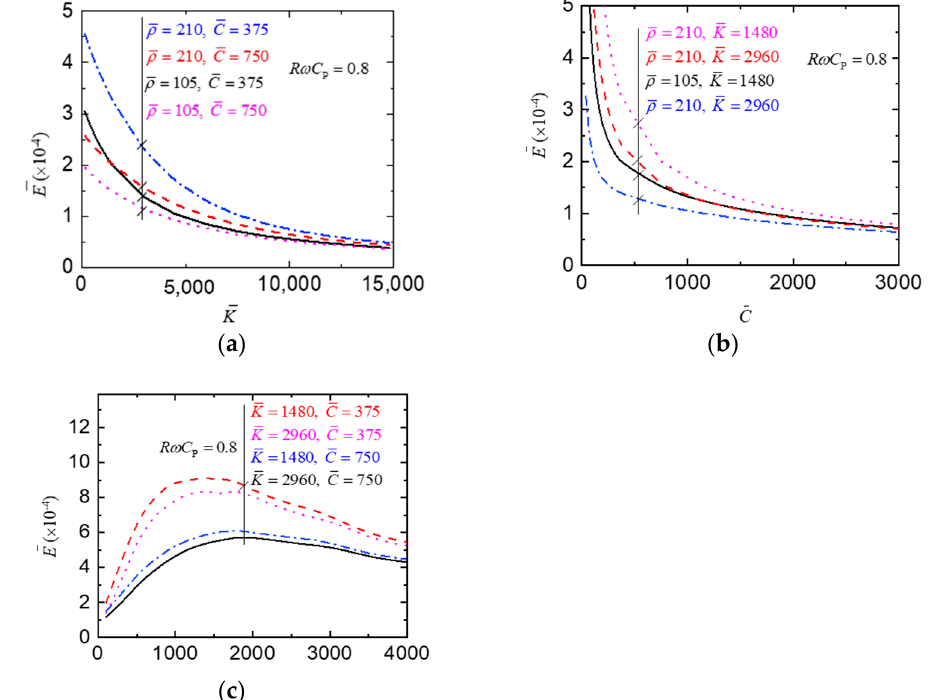
Figure 5. Influence of the normalized parameters of pavements ( K , C , ρ ) on the normalized energy E . ( a ) Influence of normalized foundation stiffness K . ( b ) Influence of normalized foundation damping coefficient C . ( c ) Influence of normalized linear density ρ